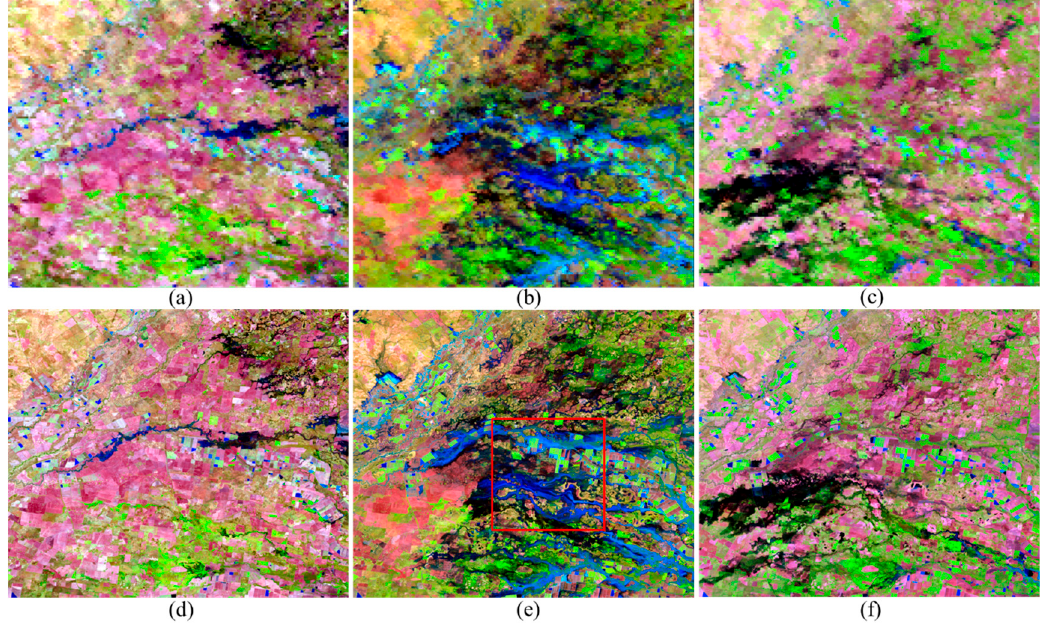
Figure 7. Illustrating image-pairs of LGC. ( a – c ) are MODIS data on the 7th, 8th, and 9th dates, respectively, and ( d – f ) are the Landsat data on the same dates as MODIS.